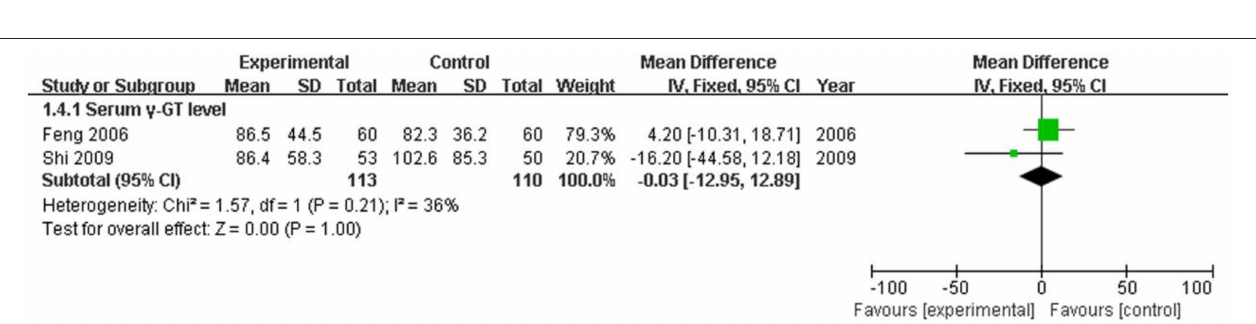
FIGURE 6 | Forest plot of ALB in treatment. (1) Study item displayed as the first author with the publication year. (2) The index of serum ALB was assessed in RCTs. (3) I-squared and P are the criterion of the heterogeneity test, (cid:7) pooled mean difference, — (cid:4) — mean difference, and 95% confidence interval.